Question: Express in one sentence what the figure is showing.
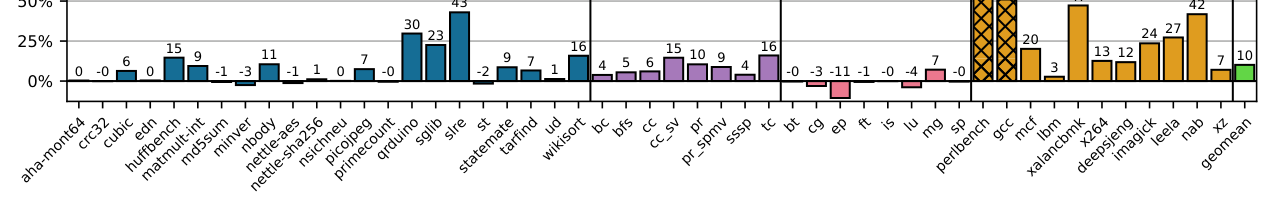
Answer: The Alaska prototypes’ overhead (% increase) from translation and pin tracking is about 10% with several outliers